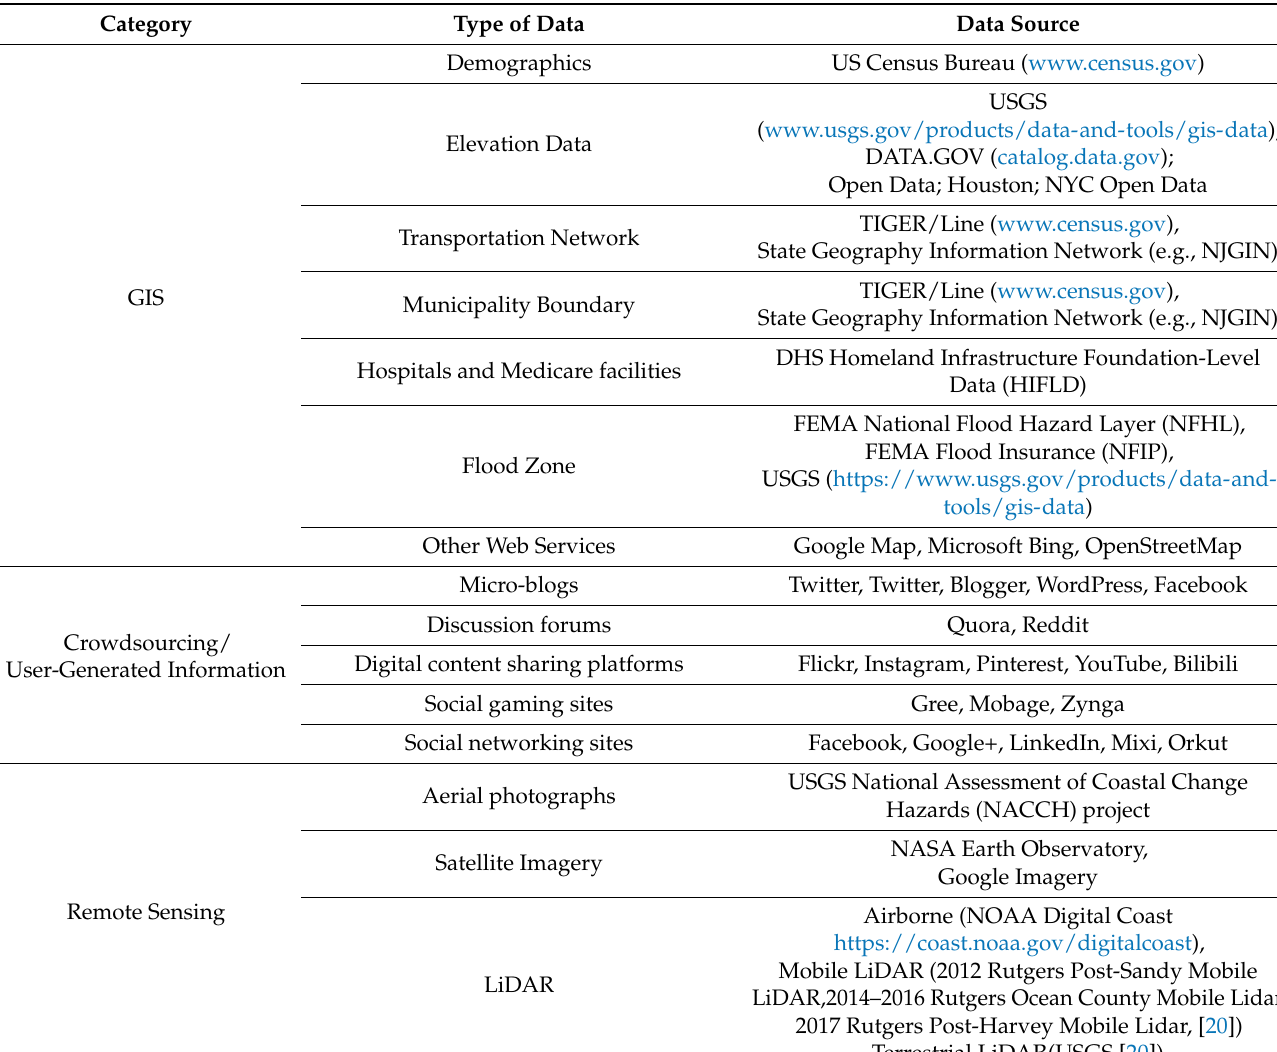
Table 2. Summary of the availability of